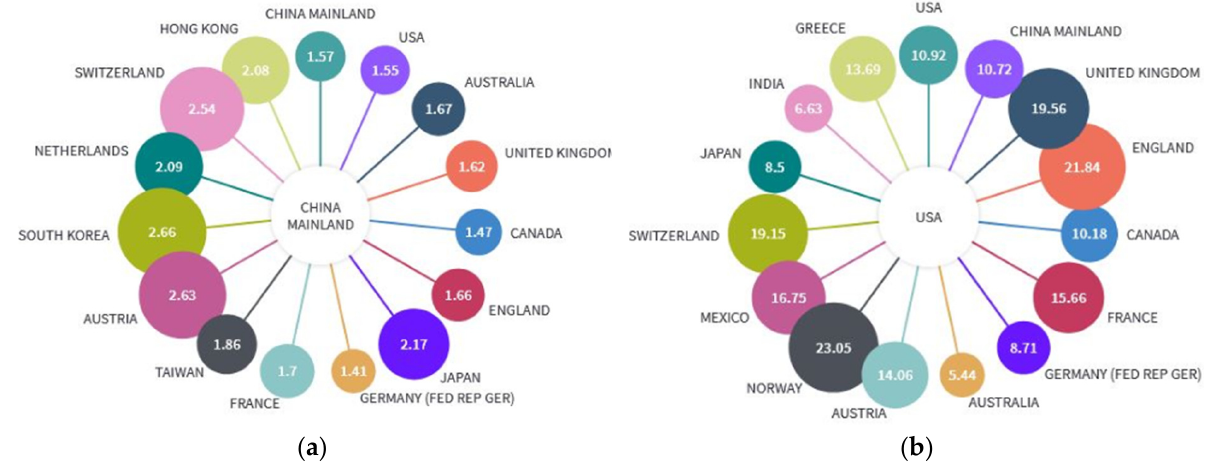
( b ) Figure 5. Percentage of cited documents in international collaboration for China ( a ) and USA ( b ). Another insight into the problem may be achieved through the utilization of the Cat- egory Normalized Citation Index (CNCI). Normalization, in general, helps to analyze a single publication in a wider context. As an example, a paper’s citation count does not